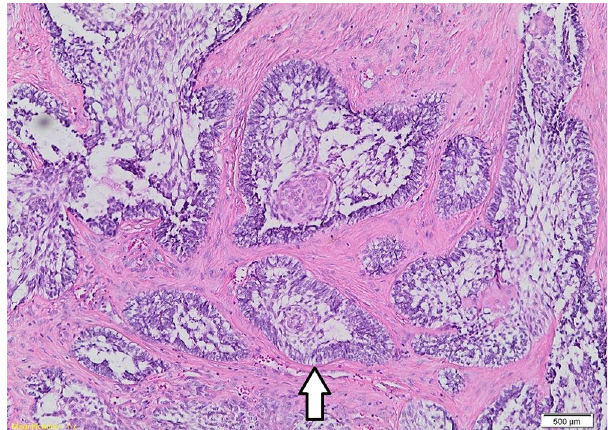
Fig. 9. H&E stained specimen showing follicular-plexiform amelo- blastoma.